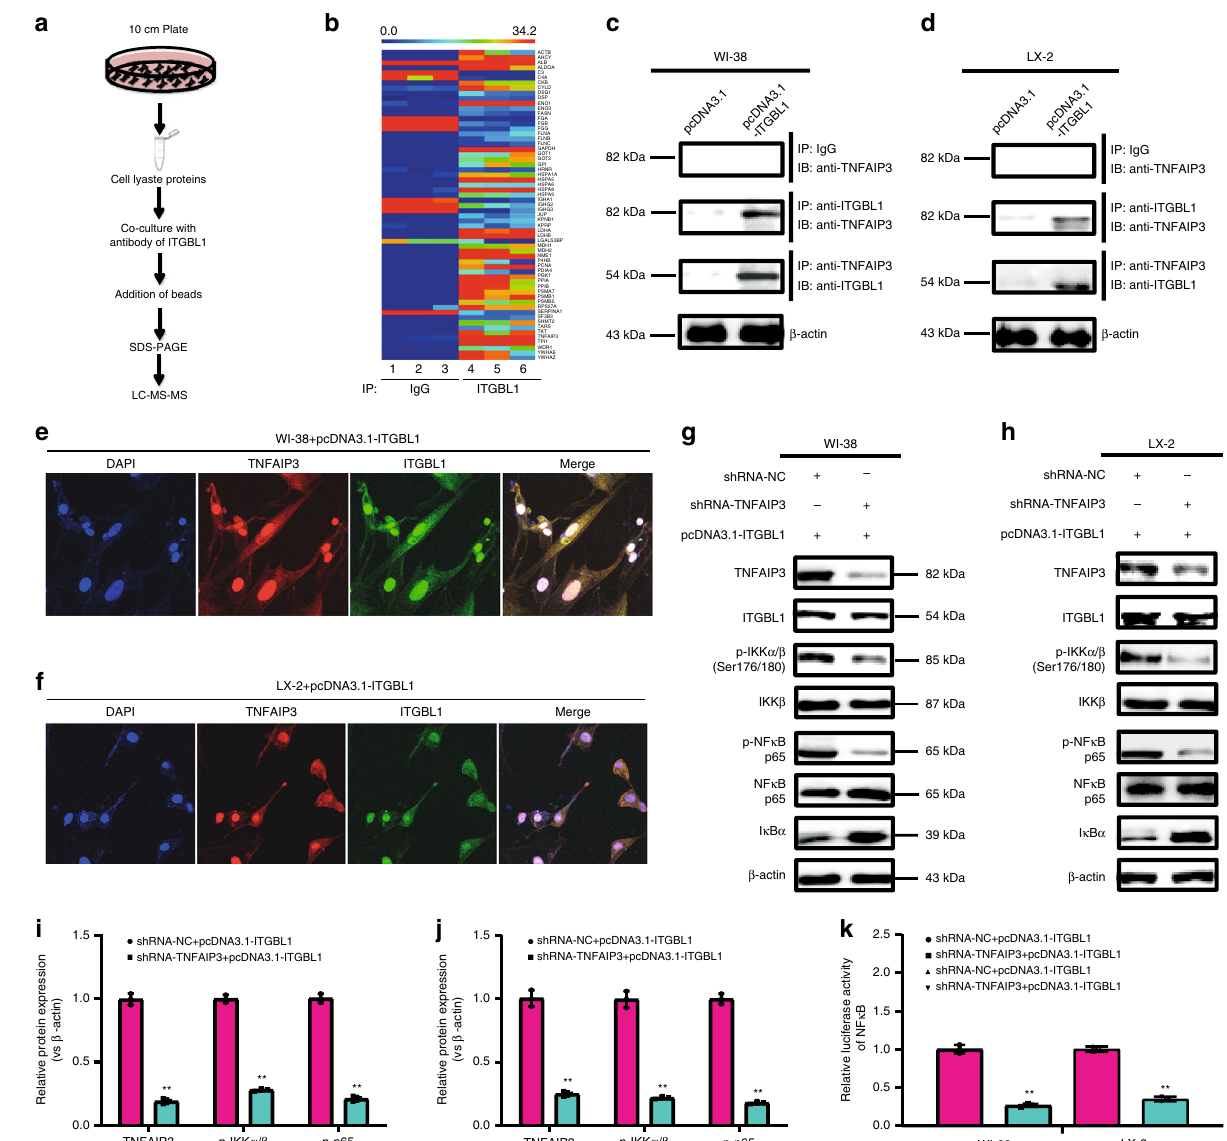
Fig. 6 TNFAIP3 was a direct binding partner of ITGBL1 in NF- κ B signal-mediated fi broblast activation. a The schematic procedure of probing the binding partners of ITGBL1 in fi broblasts by Co-IP and LC-MS/MS analysis methods. b Co-IP, LC-MS/MS, and cluster analysis of the binding proteins for targeted ITGBL1 protein using the ITGBL1 antibody (samples 4, 5, and 6) or control IgG (sample 1, 2, and 3) in ITGBL1-overexpressing WI-38 cells. Red represents high scores and green represents low scores. The color brightness of each unit is associated with differences in multiples (log 2[AR/N]). c , d Co-IP in combination with western blot performed to validate the interaction between ITGBL1 protein and TNFAIP3 protein in ITGBL1-overexpressing WI-38 and LX-2 cells, or control cells. e , f Immuno fl uorescence detection of the co-location of ITGBL1 and TNFAIP3 in ITGBL1-overexpressing WI-38 and LX-2 cells, or control cells. Scale bar, 50 μ m. g – j Western blot and quantitative assay of TNFAIP3, p-IKK α / β , and p-p65 in TNFAIP3-silent or/and ITGBL1-overexpressing WI-38 and LX-2 cells, or control cells. Figure 4i, j was the quantitative results for Fig. 4g, h, respectively. k Relative luciferase activity of NF- κ B in TNFAIP3- silent or ITGBL1-overexpressing WI-38 and LX-2 cells, or control cells. Each experiment was performed at least in triplicate and all the data are shown as mean ± SD. Student ’ s t -test was used to analyze the data; * p < 0.05, ** p <